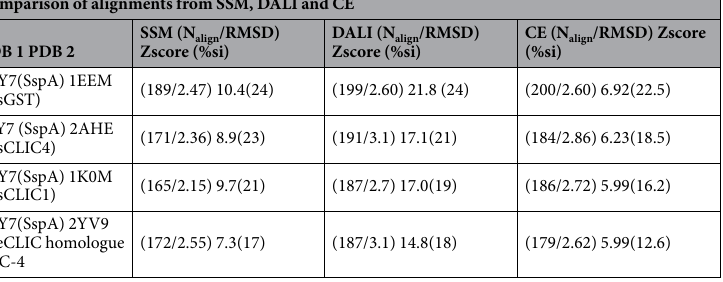
Table 1. Comparison of SspA with GTS, CLIC1, CLIC4 and EXC-4. %si = % sequence identity by individual program. MSD = root mean square distance between PDB1 and PDB2. Comparison of crystal structures of